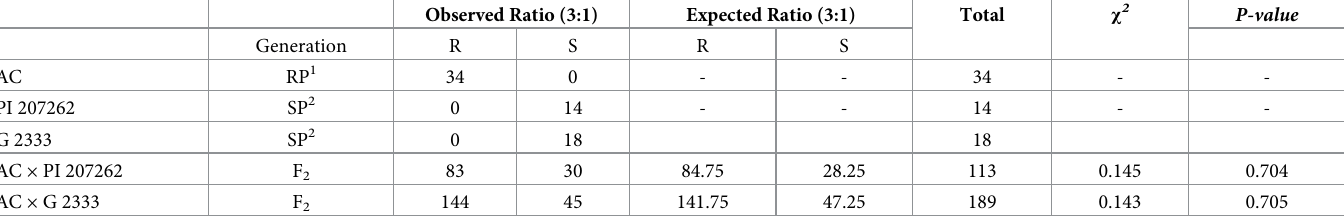
Table 2. Inheritance of anthracnose resistance in the Andean common bean cultivar Amendoim Cavalo (AC) using two mapping populations; AC × PI 207262 and AC × G 2333. Observed Ratio